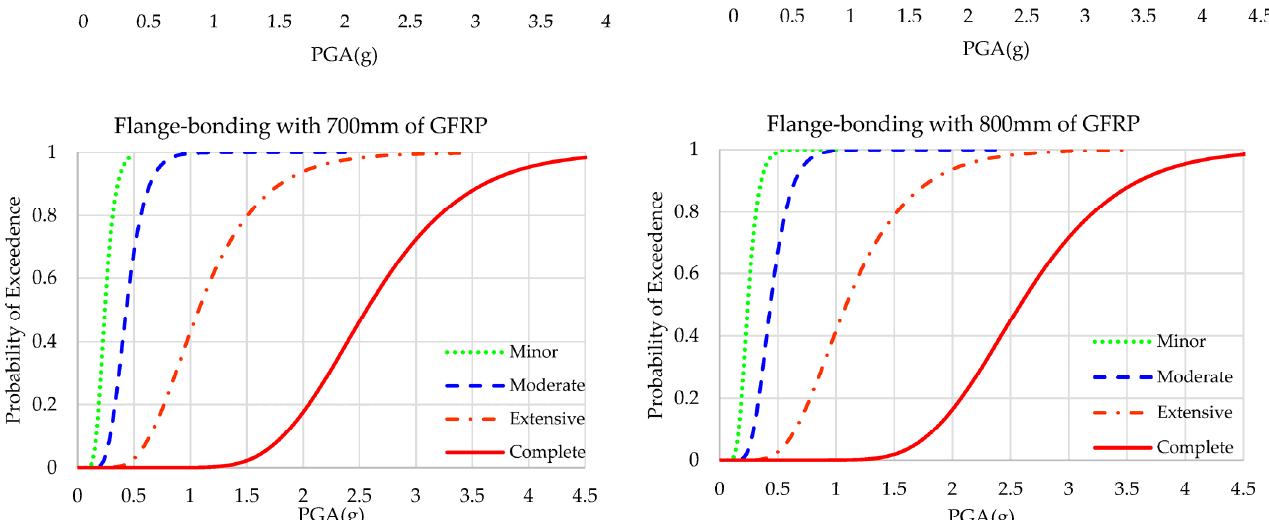
Figure 12. Fragility curves of the original and GFRP flange ‐ bonding frames in each state.